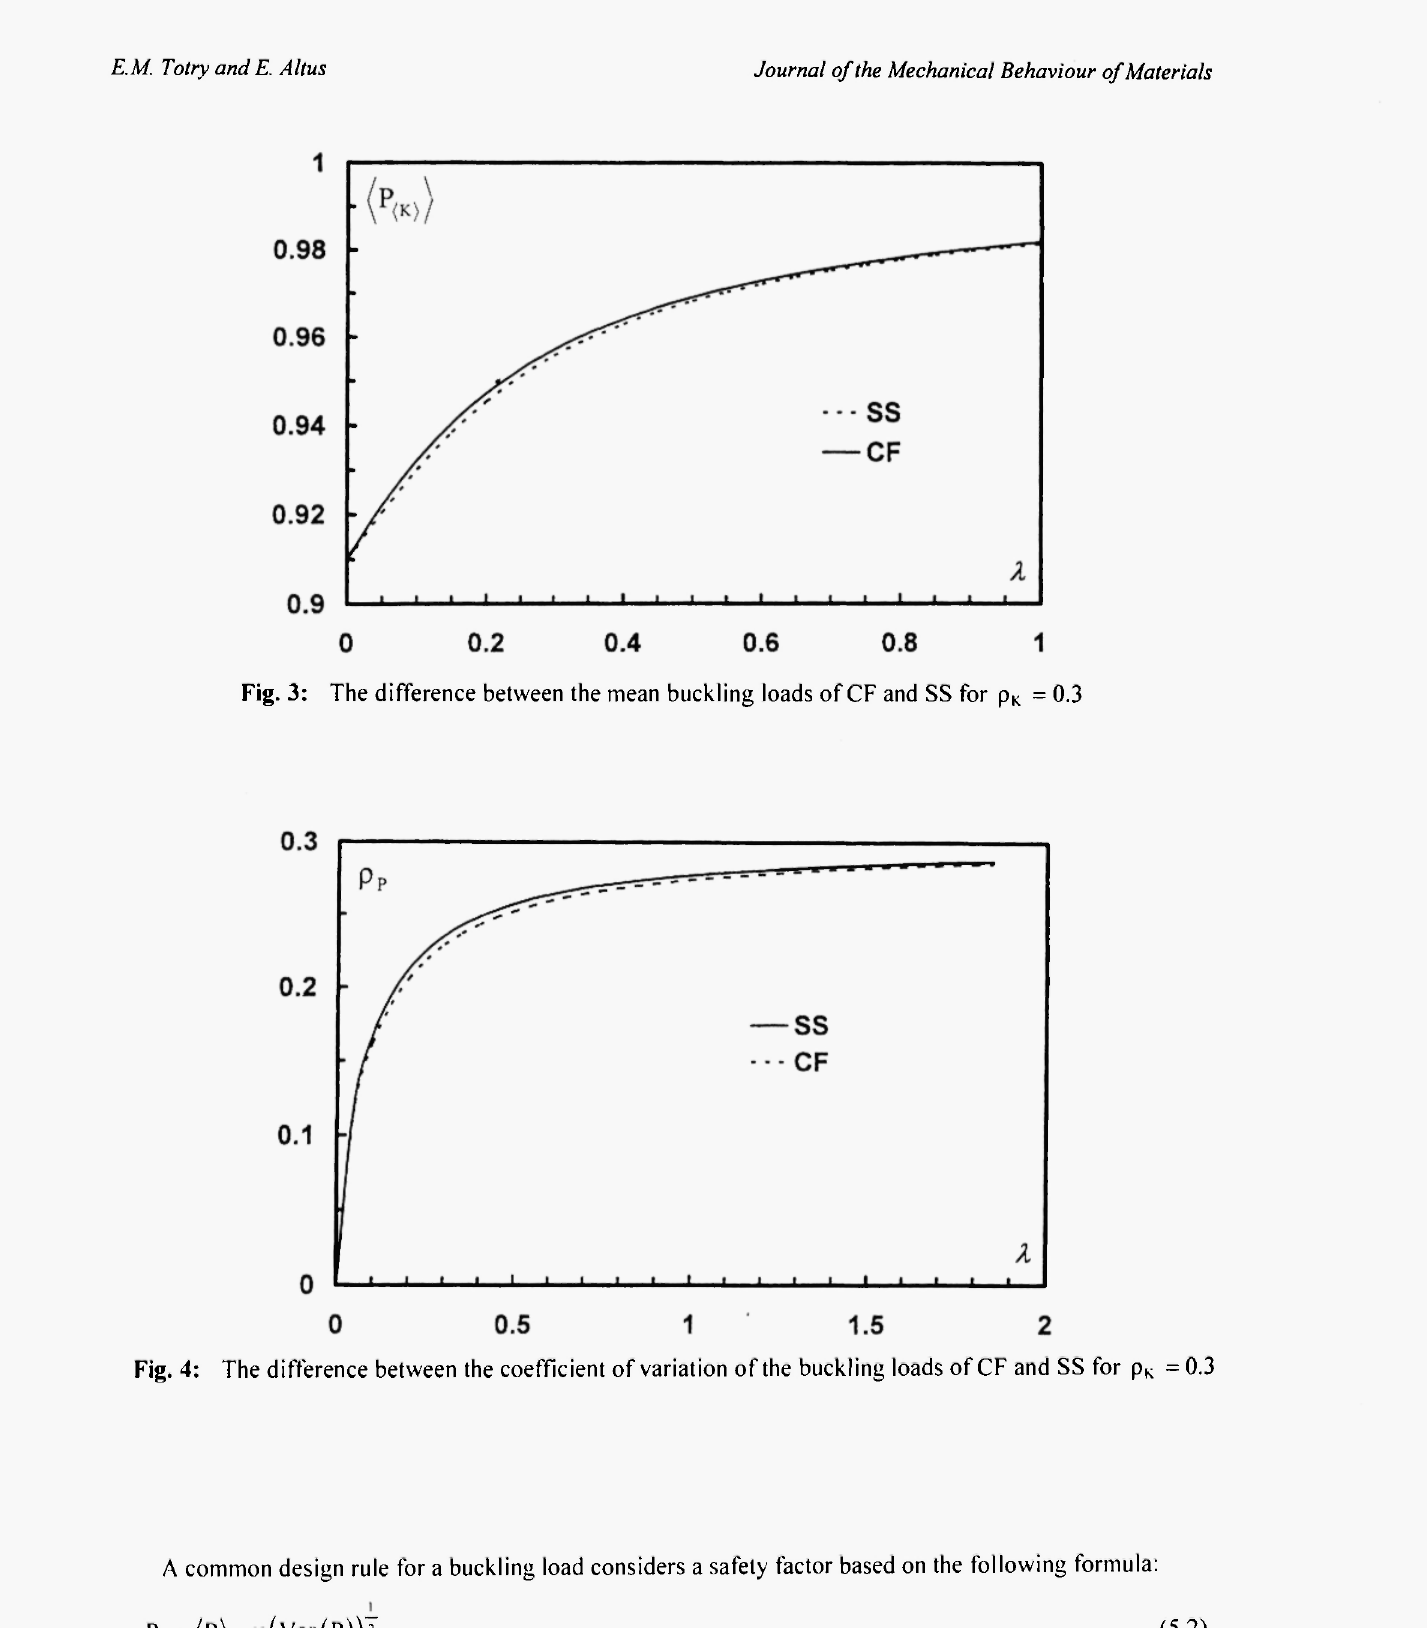
Λ common design rule for a buckling load considers a safely factor based on the following